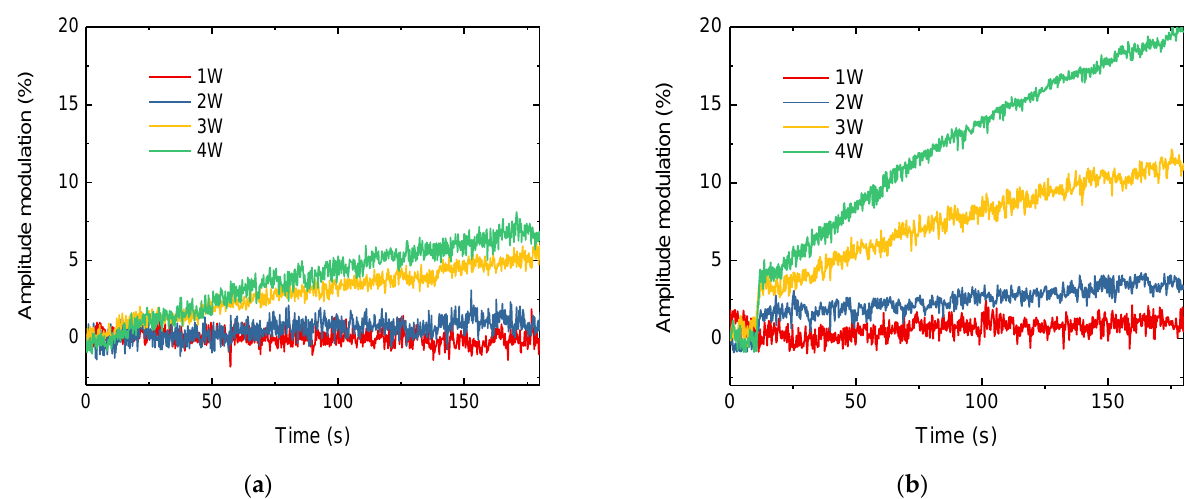
Figure 4. Time sequencing data of the peak-to-peak values of terahertz pulses of ( a ) emeraldine base (EB) and ( b ) emeraldine salt (ES) polyaniline (PANI) solutions based on the power of the continuous-wave near-infrared (CW-NIR) laser. The laser was irradiated on the solution after 10 s. The legend indicates the power of the CW-NIR laser with a wavelength of 808 nm.